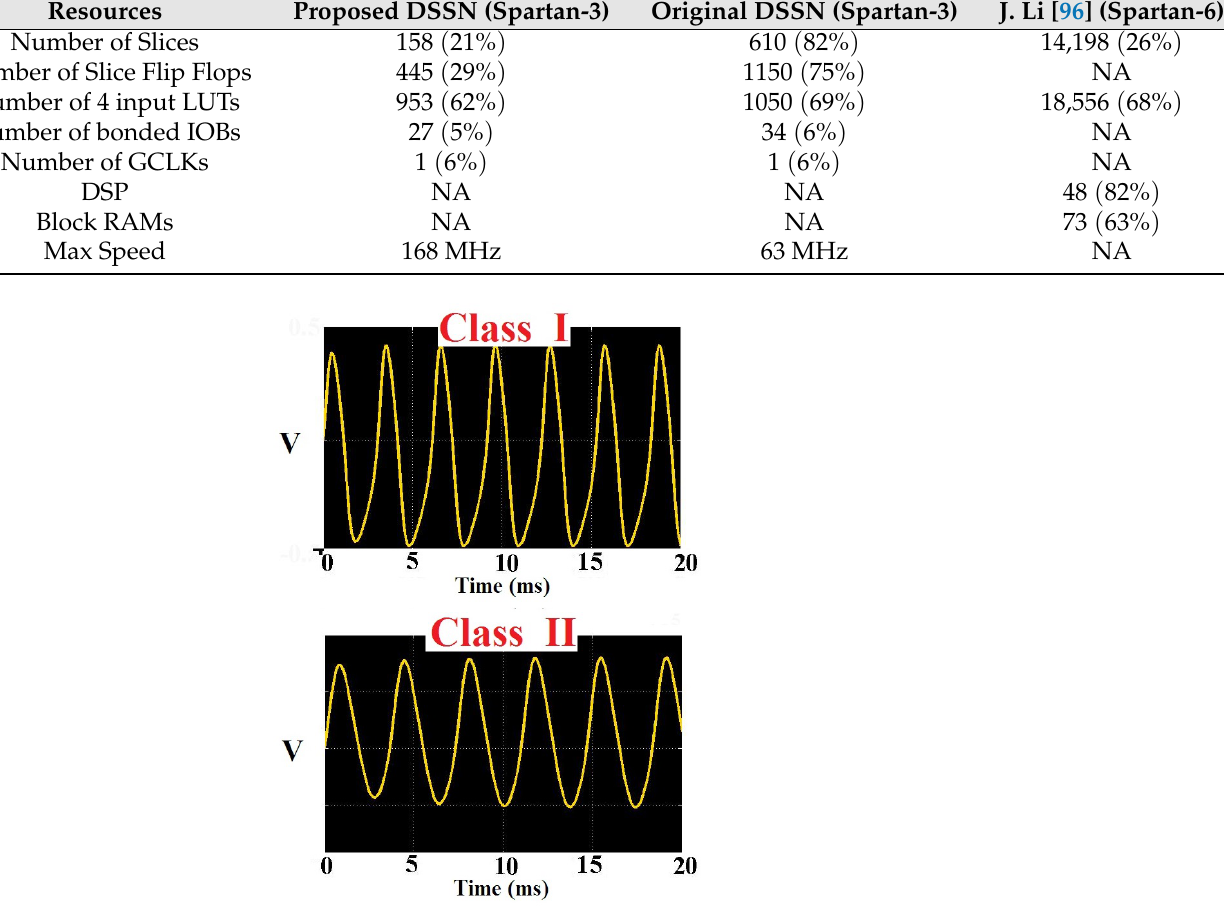
Figure 11. Digital oscilloscope for the proposed output signals (class I and class II in terms of I Stimulus = 1). Two basic spiking patterns (Class I and Class II) are presented for the voltage